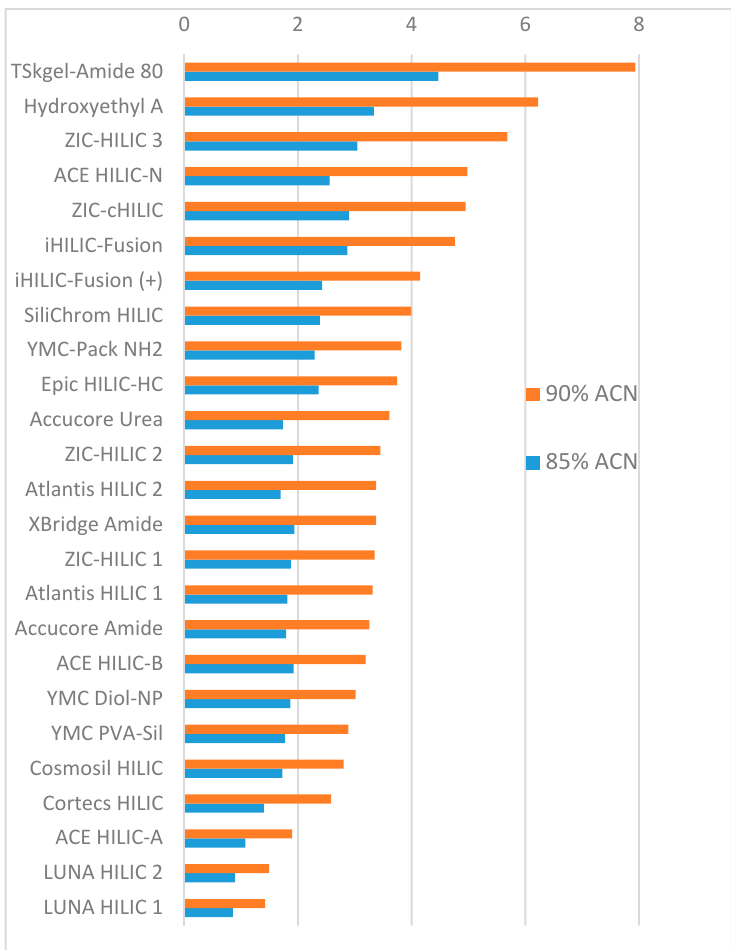
Figure 2. Cytosine retention factors on 25 polar stationary phases measured in the mobile phase containing 85% and 90% acetonitrile. Ammonium acetate concentration remains at 5 mM.